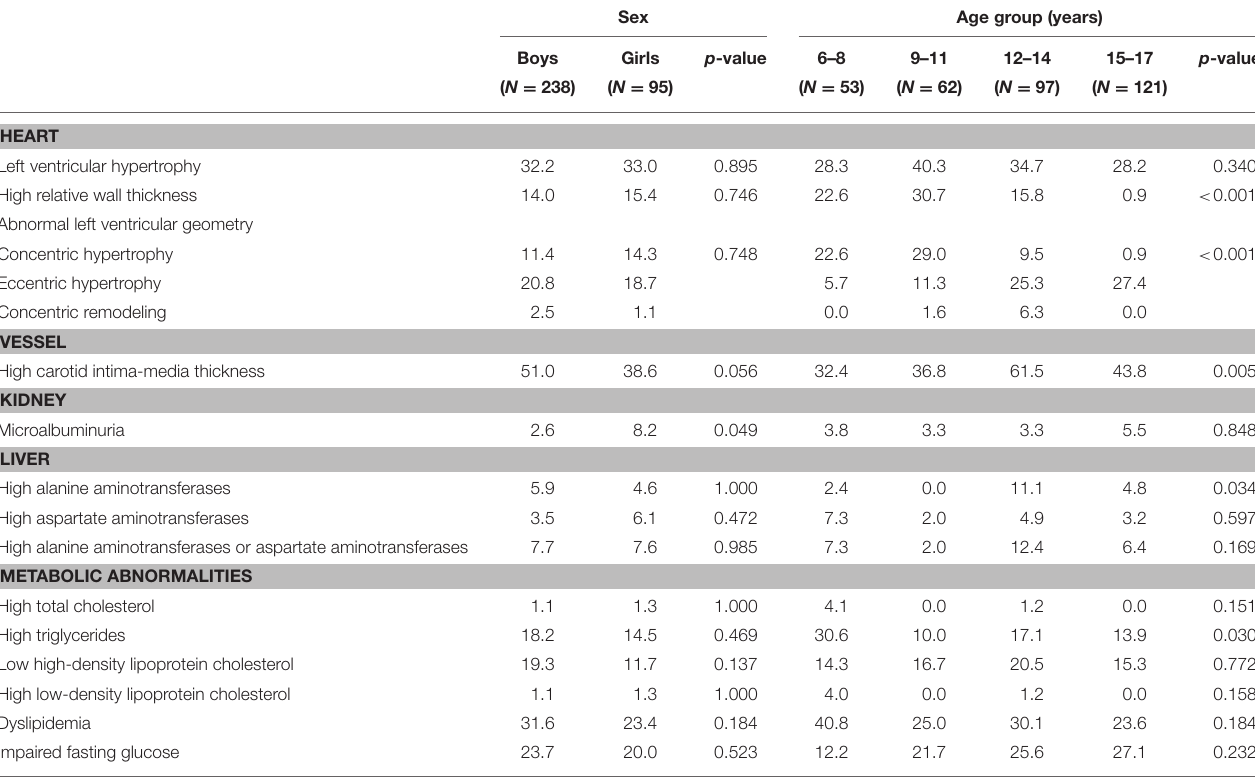
TABLE 3 | Prevalence of target organ damage and metabolic abnormalities by sex and